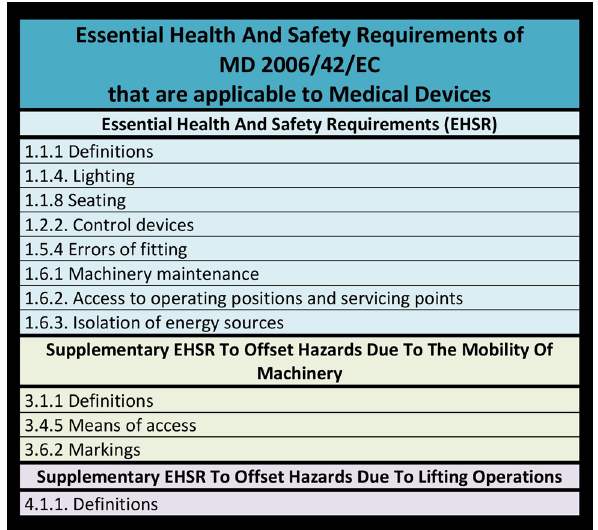
Figure 1: Applicable Essential Health and Safety Requirements ( EHSRs ) of the Machinery Directive ( 2006/42/EC ) to Medical